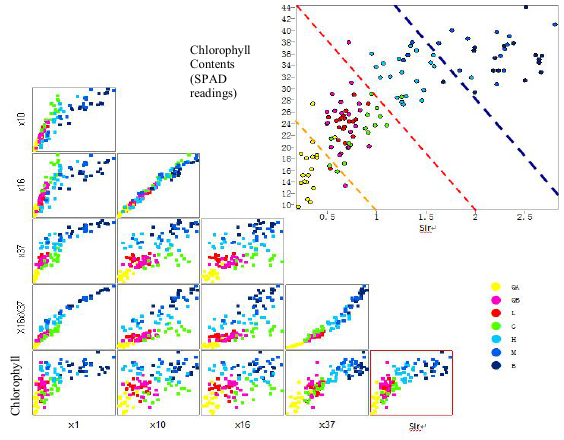
Figure 4. Correlation between the degree of pollution stress and vegetation index, chlorophyll content in Rice